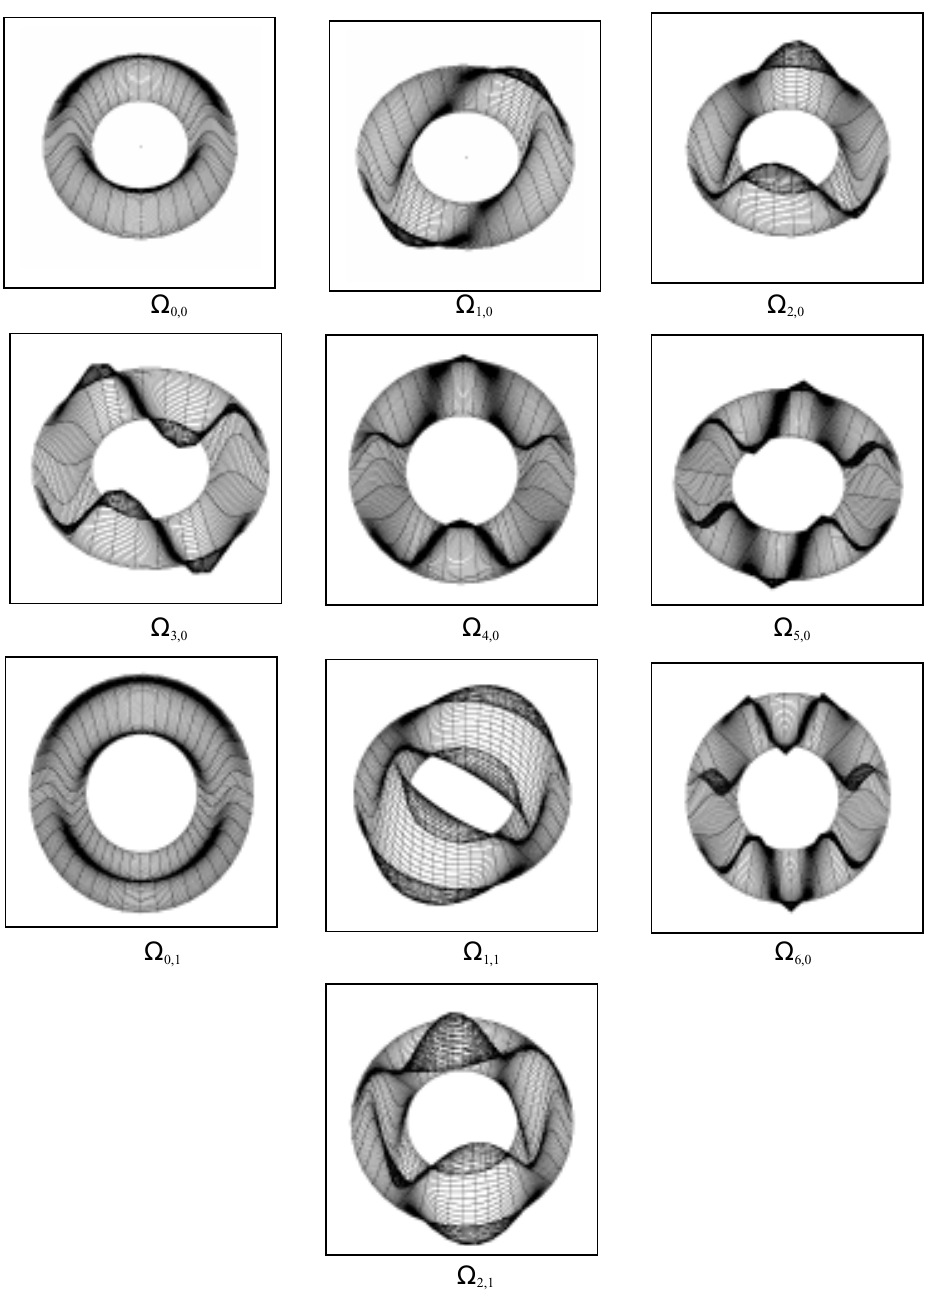
Fig. 5. Three dimensional plots for first ten normal modes of vibration for C - C plate when α = β = 0 . 4 , e r = g r = 5 . 0 , R 0 = 0.5, K f =